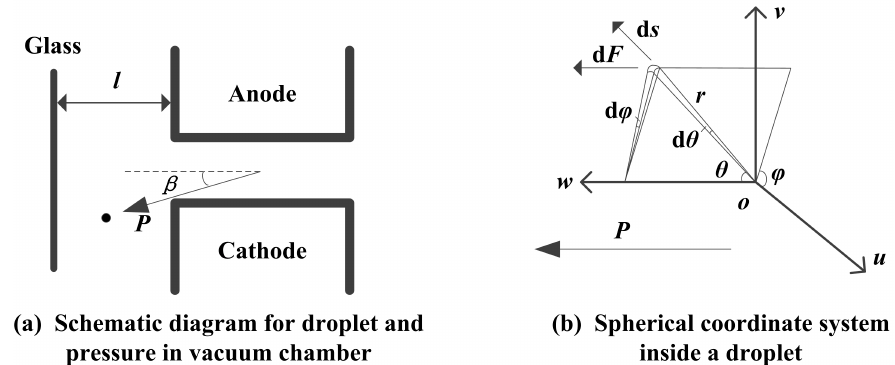
Figure 9. Movement and pressure of metal droplet in vacuum chamber.